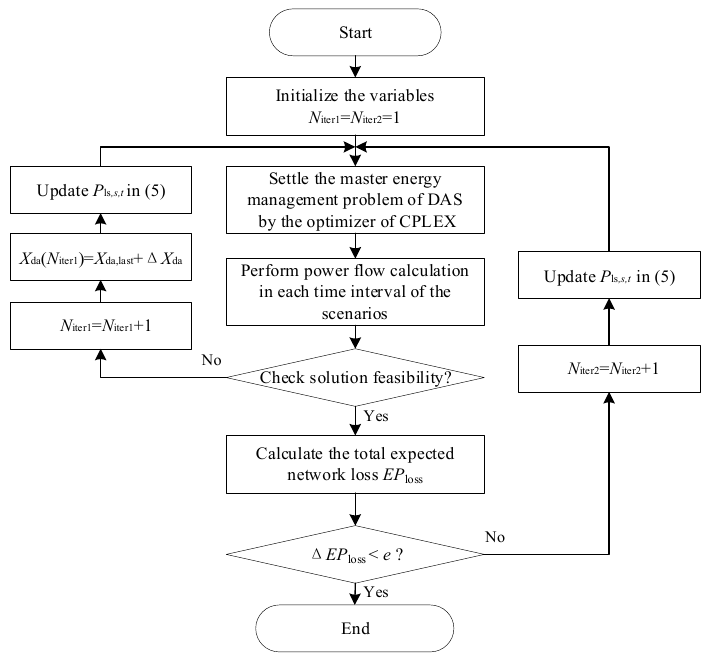
Figure 2. Flowchart of the iterative solution for the DAS.